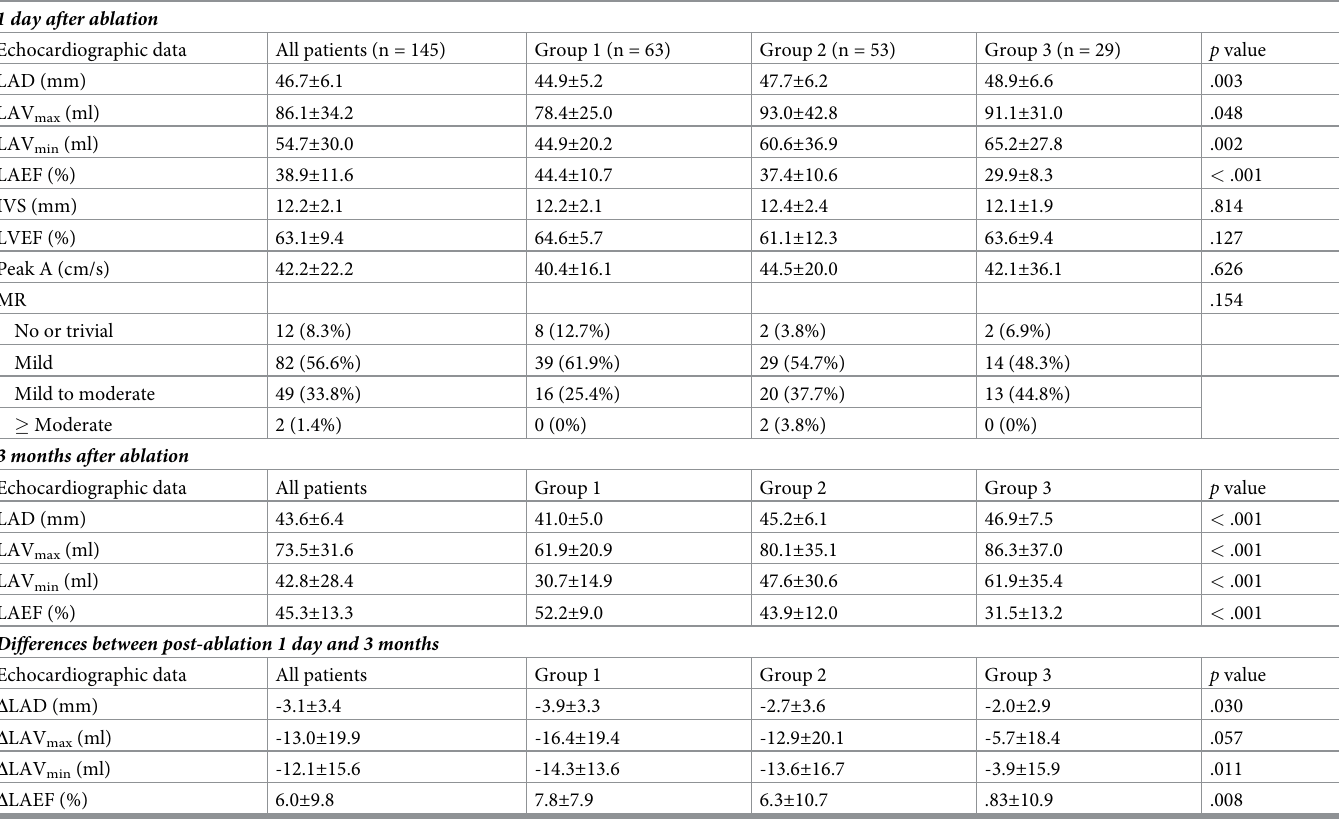
Table 2. Echocardiographic data of the study groups.